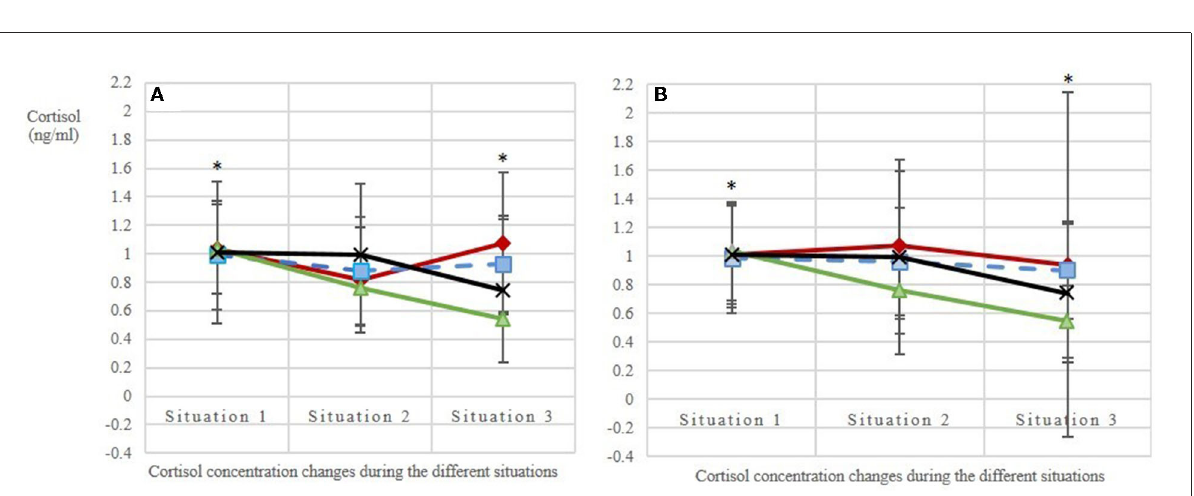
FIGURE5 Salivary cortisol levels (A) in the first replicate (observation days balanced, the 1st day of each treatment is given: days 3, 7, 2, 1; N = 10 horses; n = 116 analyzed saliva samples) and (B) in the second replicate (observation days balanced, the 2nd day of each treatment is given: days 5, 8, 6, 4; N = 10 horses; n = 120 analyzed saliva samples). Situation 1: base value before feeding; situations 2 and 3: stress values 1 and 2, respectively, during feeding with an interval of ∼ 15min. The treatments included three animal-to-feeding-place ratios (red line with ♦ = 1:1.2; blue dashed line with | = 1:2; green line with N = 1:3) and a control (black line with X = C, single feeding in the grooming area). Stars mark the statistically significant decrease of salivary cortisol concentrations ( 1 ) between situations 1 and 3 in treatments AFR 1:3 and C as compared with